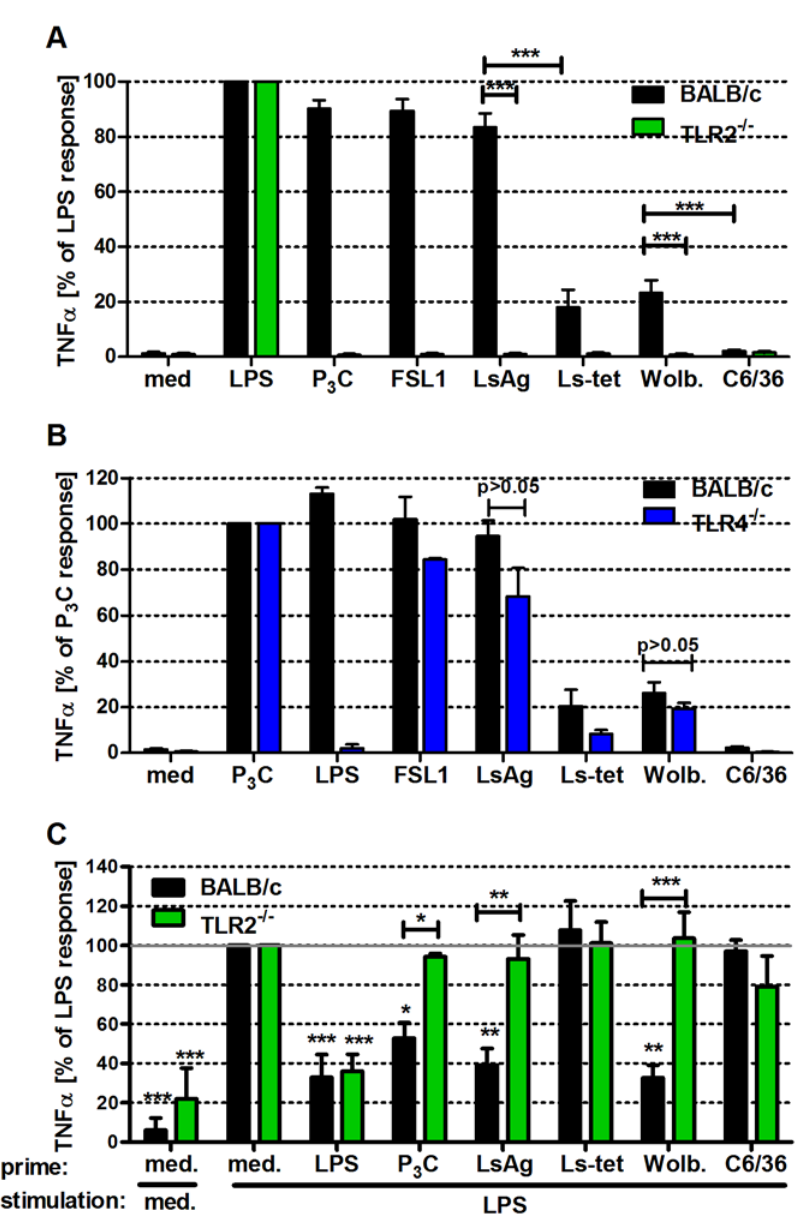
Figure 5. Macrophage stimulation with Wolbachia -containing preparations induces TLR2-dependent TNF α secretion and tolerance to subsequent LPS stimulation. Thioglycollate-elicited peritoneal macrophages from wild type and either TLR2- ( A ), or TLR4-deficient ( B ) mice were stimulated with TLR4- ( E. coli -LPS) and TLR2- (P 3 C, FSL1) specific ligands, L. sigmodontis adult worm extract (LsAg), LsAg from Wolbachia -depleted worms (Ls-tet), Wolbachia -infected (Wolb.) and sterile preparations of C6/36 insect cells. TNF α concentrations relative to LPS ( A ) and P 3 C ( B ) responses are shown. ( C ) Thioglycollate-induced macrophages from wild type and TLR2-deficient mice were primarily stimulated (prime) for 18 hours as described above before re-stimulation with LPS for an additional 18 hours. TNF α concentrations in supernatants of F4/80 hi macrophages are plotted relative to the acute LPS response (medium prime/LPS stimulation). Shown are data representative of three independent experiments (n = 5/group for ( A, B ) and n = 3/group for ( C )). Data shown is expressed as mean + SEM and was tested for statistical significance by student ’ s t-test. Asterisks above the bars indicate significant differences compared to med/LPS condition. * p < 0.05; ** p < 0.01; *** p <